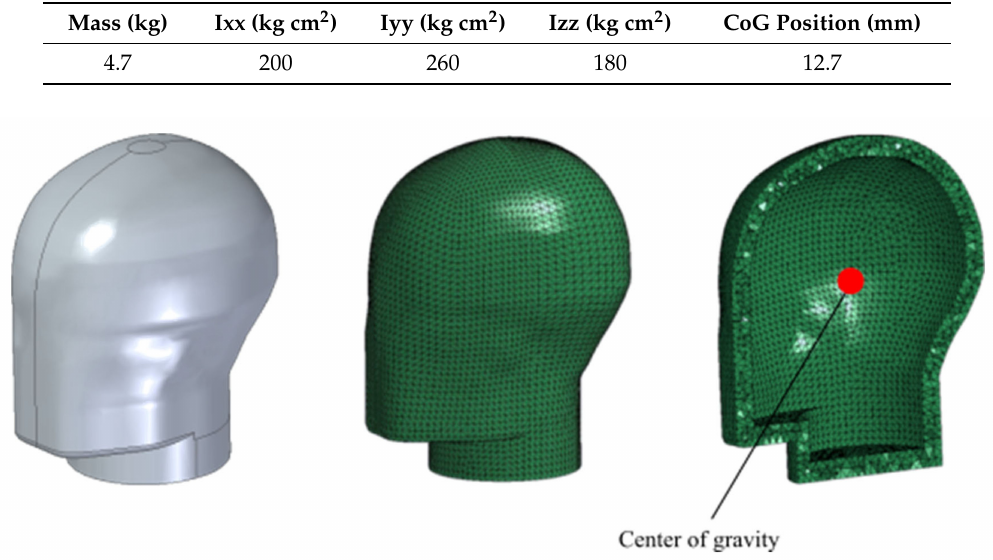
Table 4. Head surrogate inertial parameters.